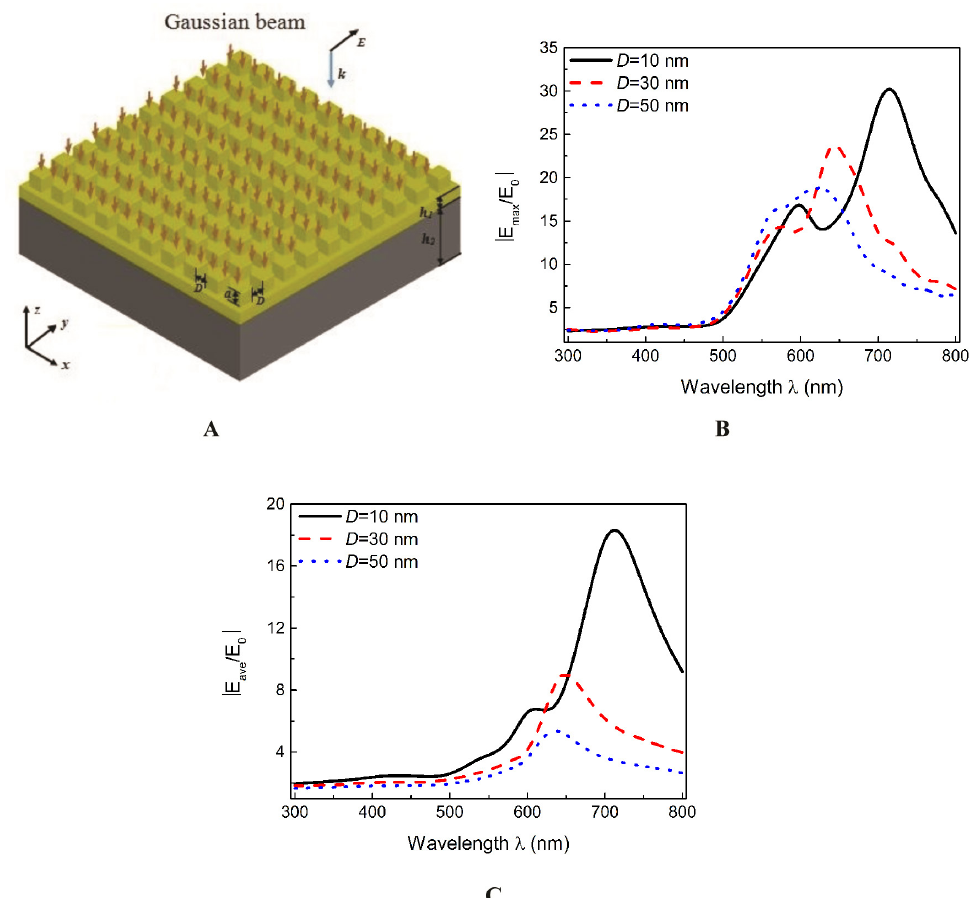
Figure 4: ( A ) Schematic diagram for the Gaussian beam incident on Au nanocube arrays; ( B ) The curve of | E max / E 0 | with the working wave- length; ( C ) The curve of | E / E 0 | with the working wavelength ( | E max | is the maximum electric field in the space area; | E 0 | =1V/m is the ave amplitude of the incident Gaussian beam; | E is obtained by averaging | E | in the whole space area) ave |